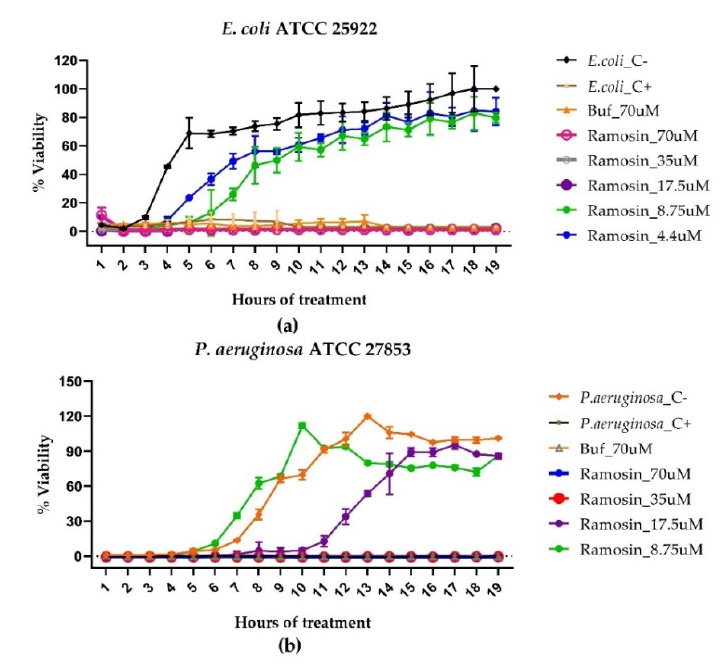
Figure 2. Growth inhibition kinetics of Gram-negative bacteria E. coli ( a ) and P. aeruginosa ( b ) treated with Ramosin peptide from B. ramosi. Absorbance reading at 600 nm every hour of treatment. Three independent experiments were carried out for each bacterial strain. Data are presented as mean ±